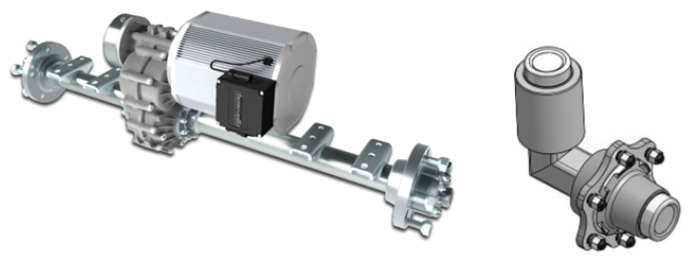
Figure 2. Rear axle and front axle shaft.